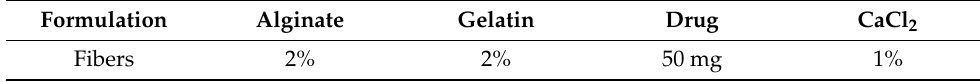
Table 1. Composition of fibers.